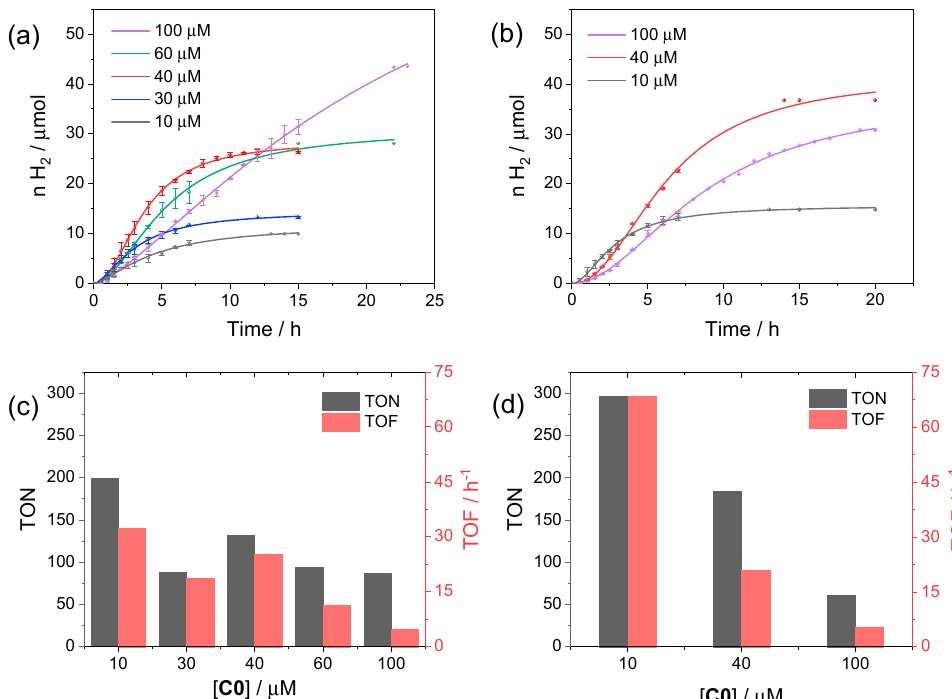
Figure 3. Kinetics of hydrogen evolution obtained upon visible light irradiation of aqueous solutions (5 mL) containing 0.11 mM CuInS 2 @ZnS QDs, 0.5 M ascorbate, and 10–100 µM C0 at ( a ) pH 4 and ( b ) pH 5; photocatalytic data at ( c ) pH 4 and ( d ) pH 5 in terms of maximum TONs after 24 h and